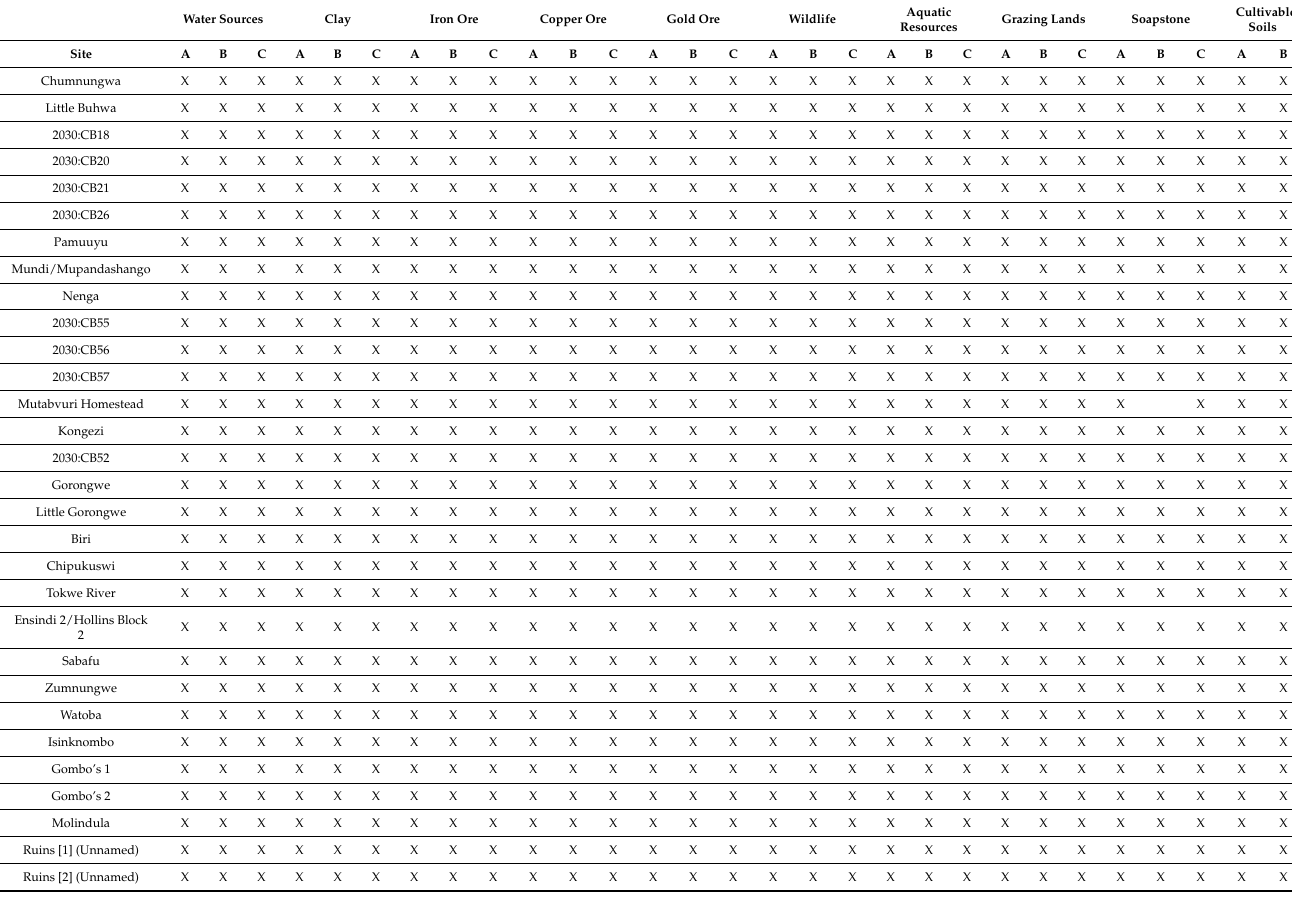
Table A1. Availability of water, minerals, wildlife, pasturage, aquatic resources, and arable land within the catchment area of Zimbabwe tradition settlements recorded in